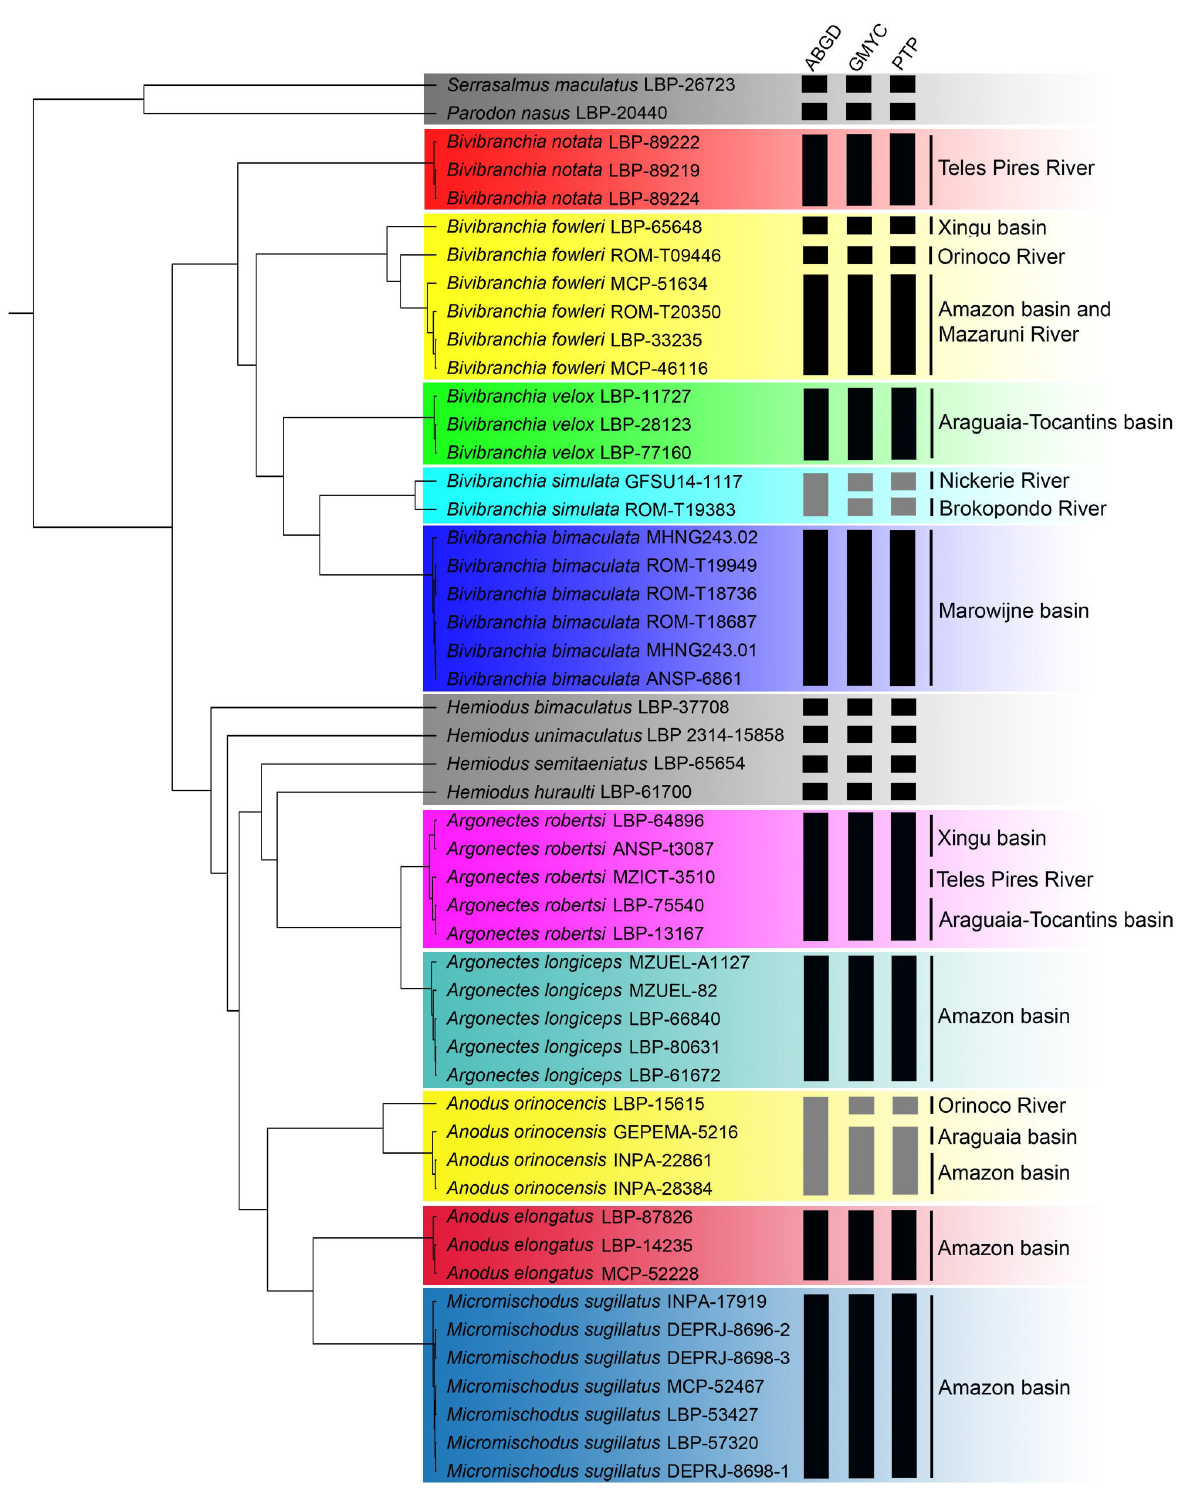
FIGURE 2 | Bayesian tree of the specimens showing the MOTUs delimited by ABGD, PTP, and GMYC methods. Congruence across methods is represented by black rectangles and discordance between them is represented by grey